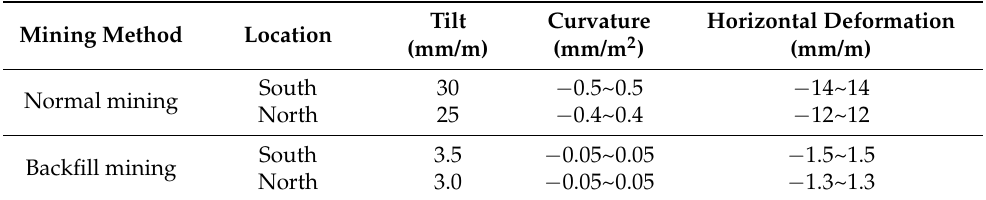
Table 5. Dynamic maximum evolution value of surface subsidence prediction between normal mining and backfill